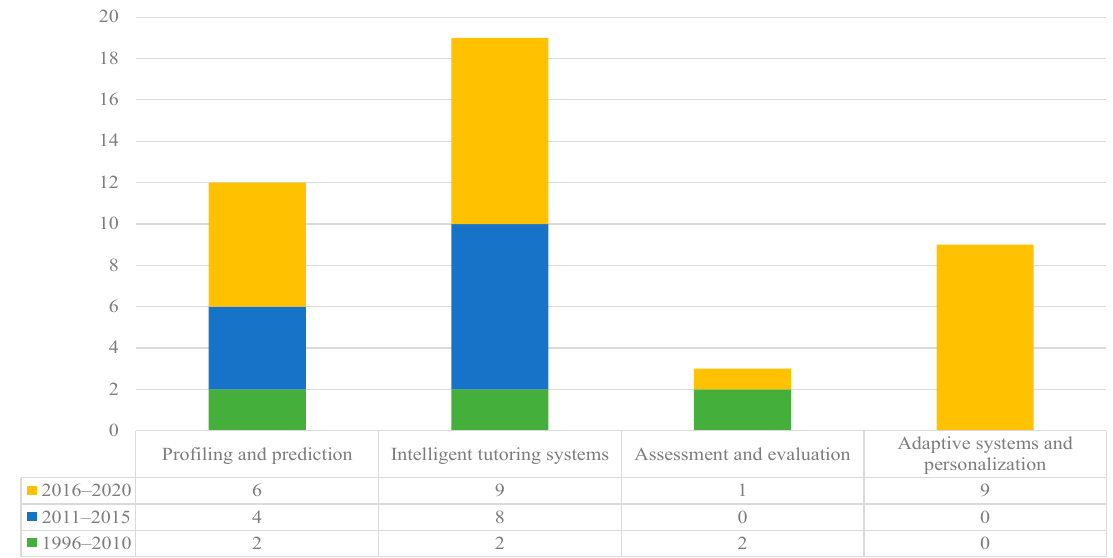
Figure 11. Roles of AIME research in each period.